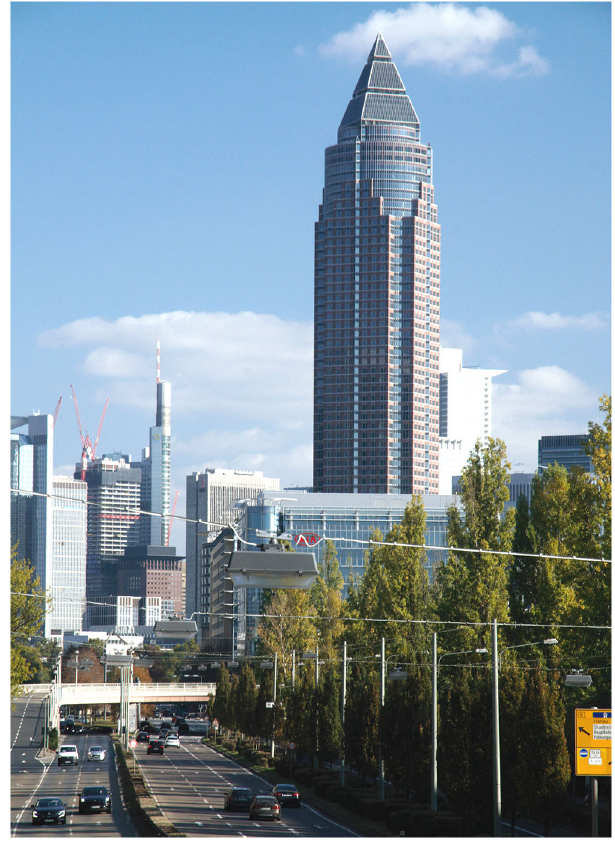
Fig. 4 The Frankfurt Fair Tower. Copyright permission by Gerd